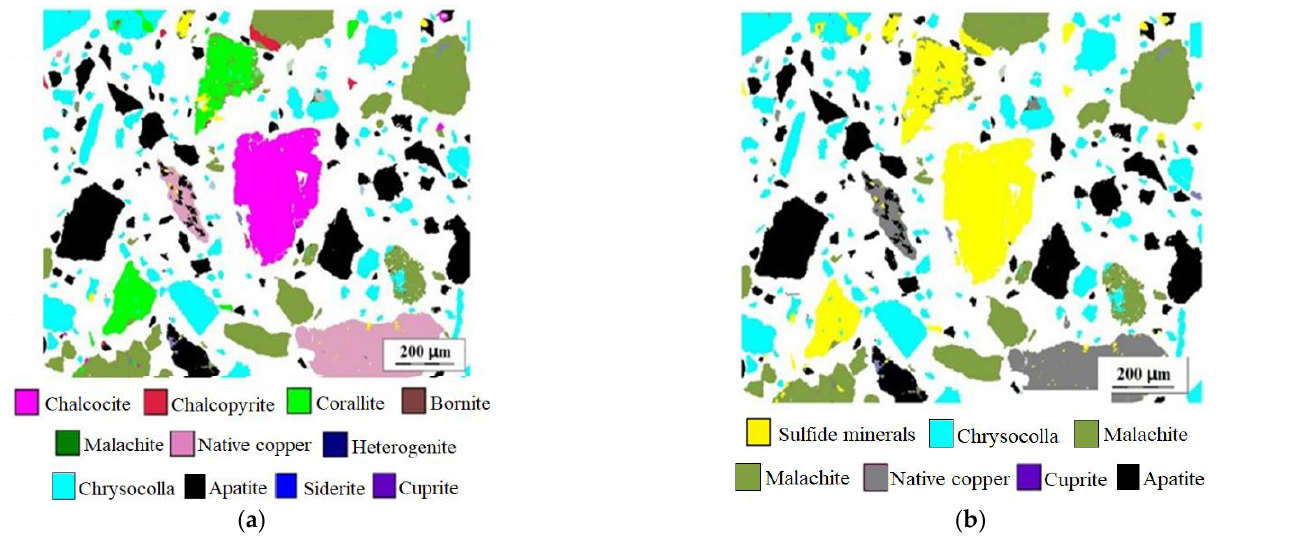
Figure 3. The mineral map of ore. ( a ) map of sulfide minerals ( b ) map of sulfide aggregation.